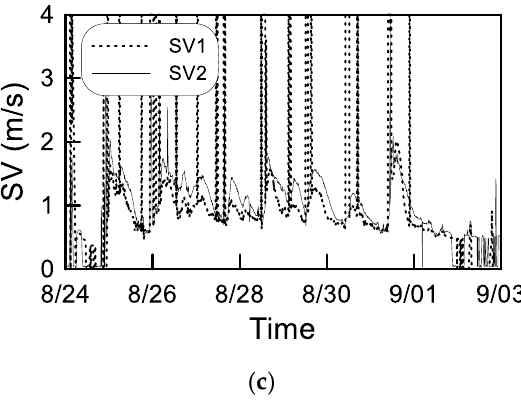
Figure 3. Local time series of WL and SV at Wulilin Bridge during a rainfall event in 2015: ( a ) SV1 and WL; ( b ) SV2 and WL; ( c ) SV1 and SV2.